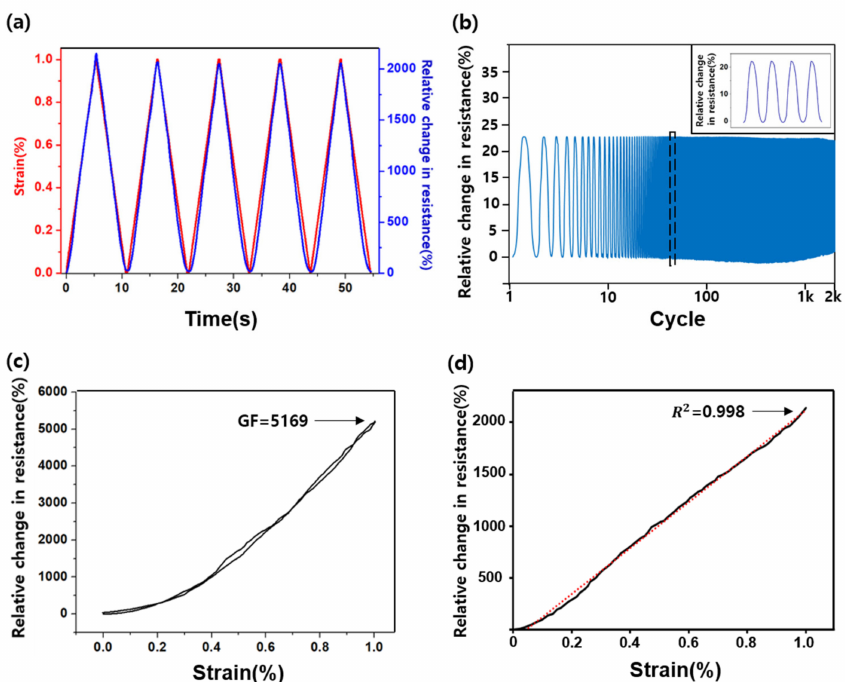
Figure 5. ( a ) Relative resistance change during the cycling at the 0–1% strain. ( b ) Relative resistance change during 2000 cycles (inlet: resistance change at specific cycles). ( c ) High GF strain sensor after the pre-strain and sensor-extending processes. ( d ) Linear strain sensor after the pre-strain and sensor-extending